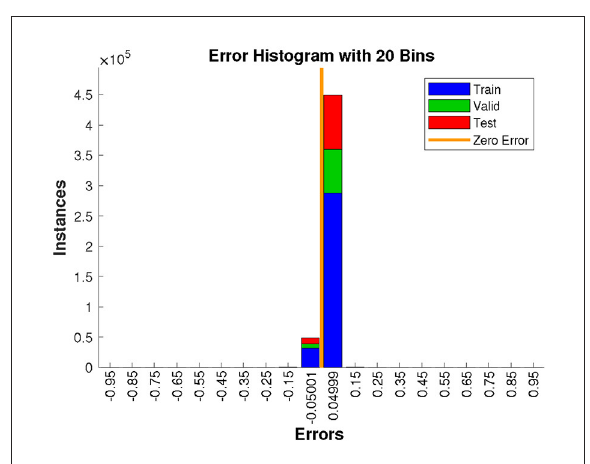
FIGURE9 Error histogram (errors